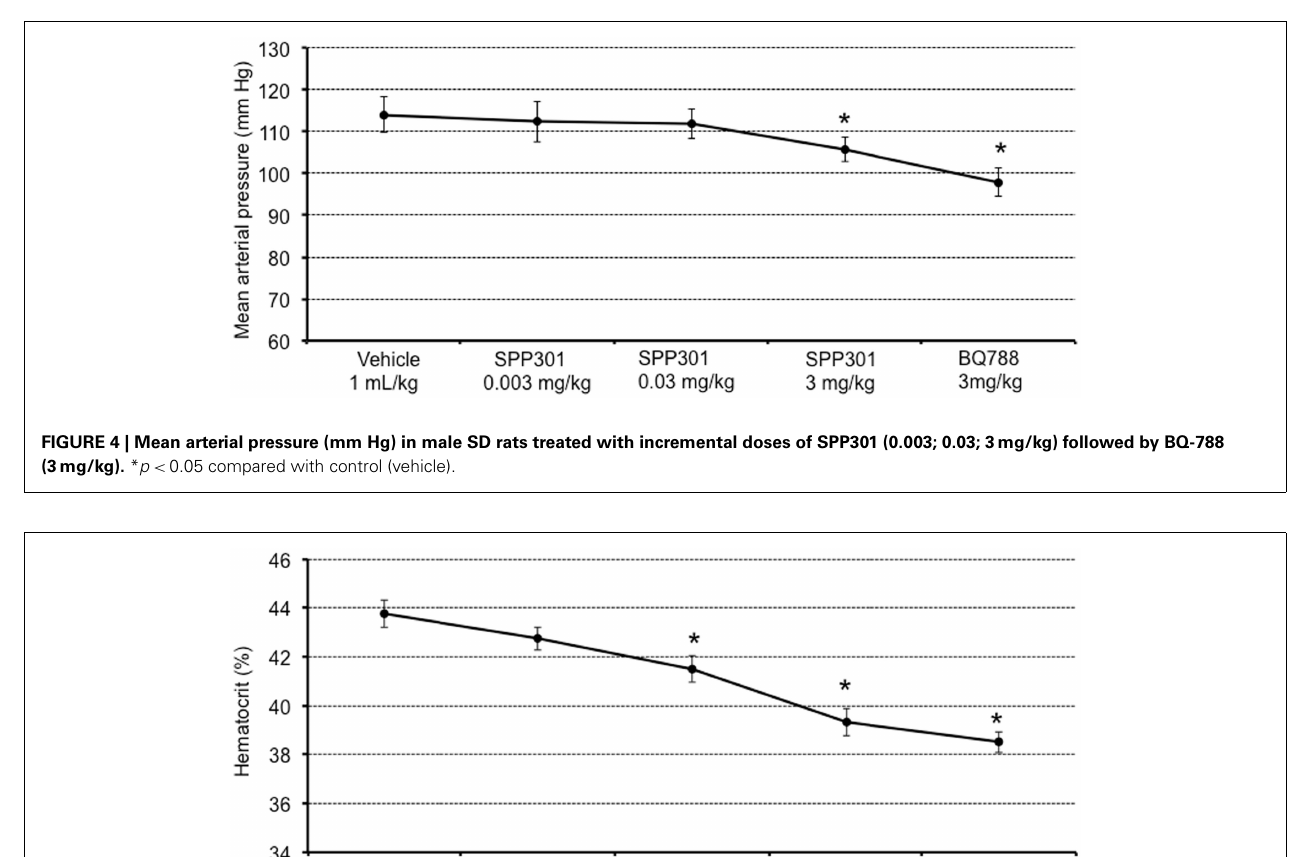
and ET A receptor activation has antidiuretic effects. These effects are mediated through altered renal sensitivity to the urinary concentrating effects of